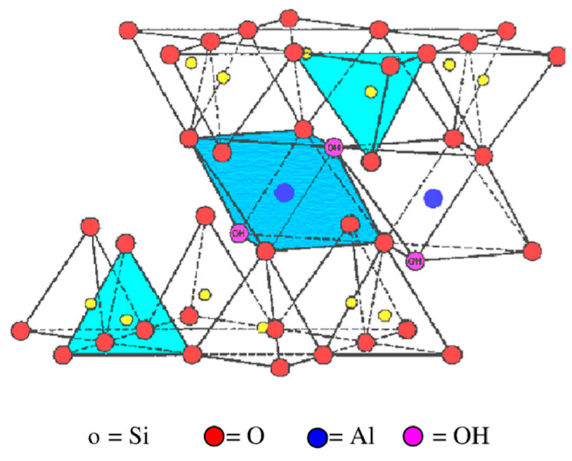
Figure 1. Structure of montmorillonite (MNT). Reproduced with permission from the authors of [21].